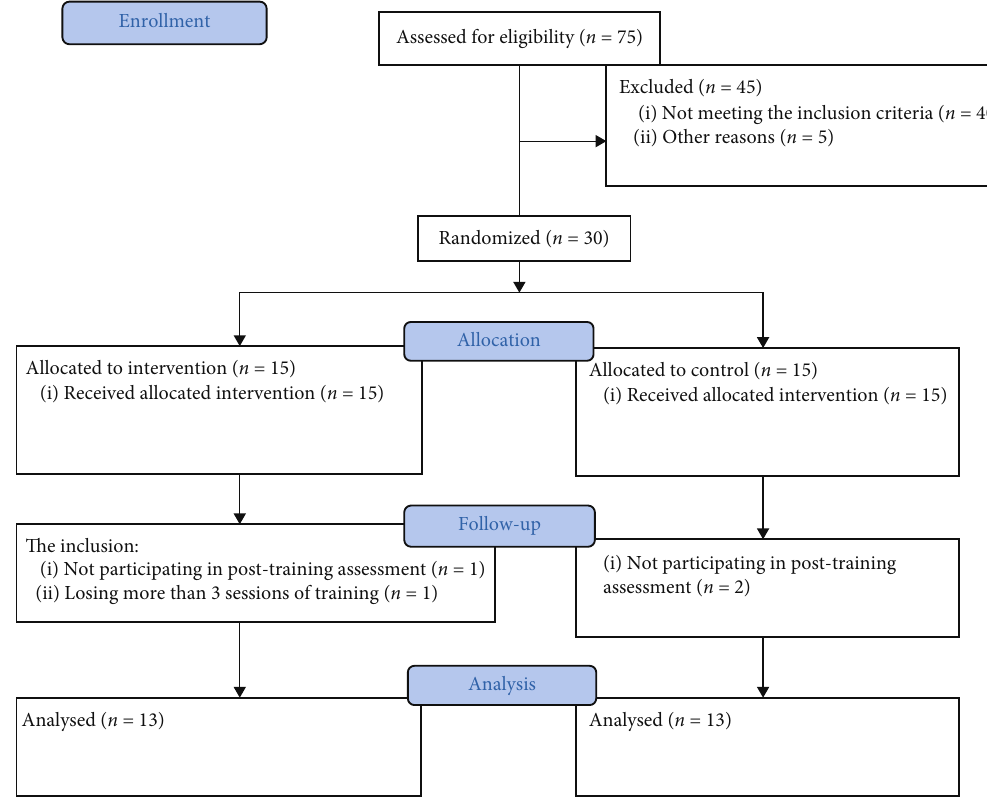
Figure 1: CONSORT fl ow chart.